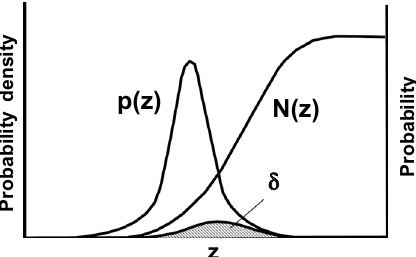
Fig. 3 The expected risk of a chemical, denoted δ, is defined as the probability that PEC is greater than NEC , where both PEC and NEC are